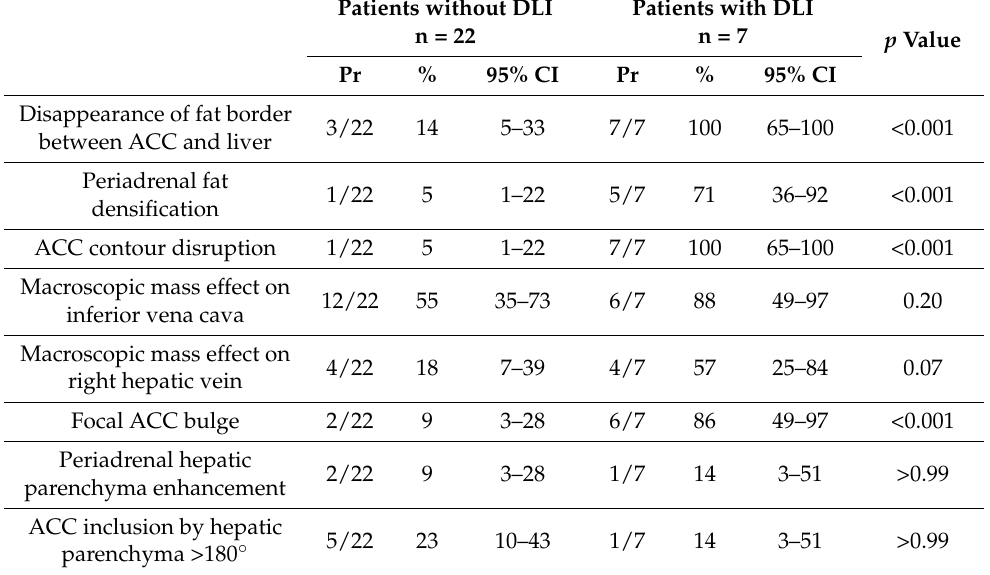
Table 4. Comparison of CT findings for independent categorical criteria between 22 patients without DLI and 7 patients with DLI.